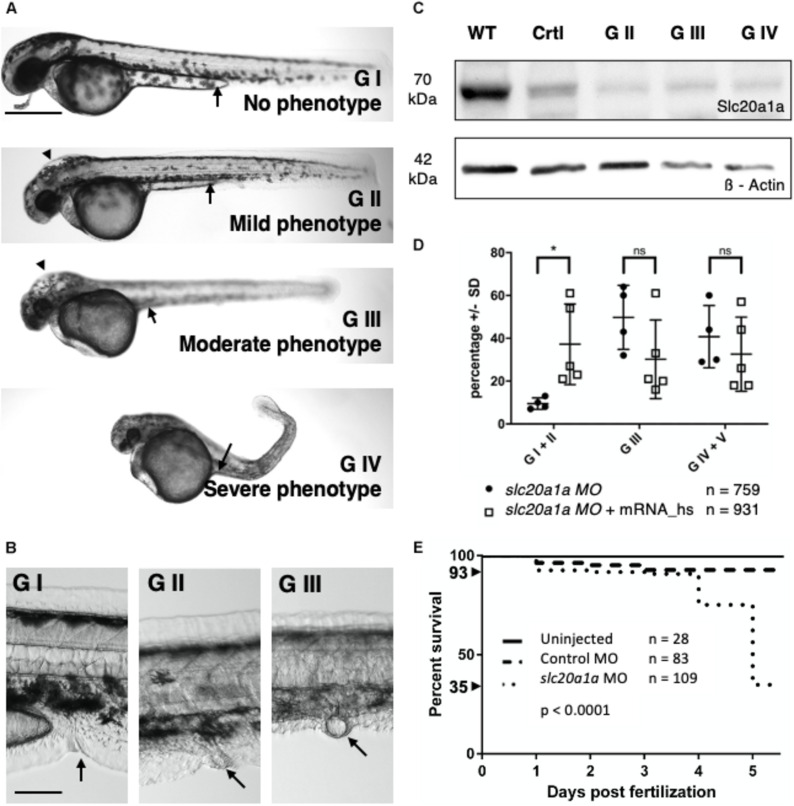
slc20a1a MO KD. KD was performed by injecting 0.75 ng of ATG-blocking MO into one-cell-staged wt zf eggs. Lateral view, dorsal to top, cranial on the left. (A) Phenotypical grading of MO injected zfl at 2 dpf in four grades increasing in severity and lethality. Scale bar: 500 μm. See main Results text for grading details. In brief, GI were normal in direct inspection; GII had mild defects; GIII had moderate defects, and GIV had severe defects. G V resembles dead zfl. Supplementary Data Sheet S3 shows close-ups for better demonstration of hydrocephalus and eye development in all four grades presented. (B) Examples for cloacal abnormalities in MO KD zfl at 2 dpf. Scale bar: 100 μm. Inspection of cloacal region after previous grading revealed malformations in cloacal region in G II and G III sorted zfl increasing in amount and severity with grading. G I sorted zfl had normal cloacal morphology, that is, a thin and curved organ with a distal opening (arrow). GII and GIII zfl have abnormally shaped cloacae, with dilated and/or apparently blind-ending lumens. Further cloacal close-ups of G II and III sorted zfl are shown in Supplementary Data Sheet S4. (C) WB shows efficacy of MO KD in zebrafish protein lysates from 2 dpf. 70 kDa: slc20a1a, 42 kDa: ß-Actin loading control; WT = uninjected control, Crtl = control MO injected, G II/III/IV = slc20a1a MO KD zfl sorted by grading II–IV. Slc20a1a can be detected in uninjected wt control and injected control MO group. Only a weak slc20a1a signal was seen in MO KD groups G II, III, and IV, which showed phenotypical features as described in (A). WB shows correlation between phenotype and protein expression. Raw data of WB is shown in Supplementary Data Sheet S6. (D) Co-injection of slc20a1a MO with 35 μg in vitro transcribed human SLC20A1 polyA mRNA shows partial rescue of various phenotypes underlining the Morpholino’s specificity. n = 5 (here n = 1 represents the average score in each experimental batch). Error bars show SD. X-axis shows groups at 3 dpf that were compared: zfl showing no or only a very mild phenotype (G I + G II), larvae with a moderate phenotype (G III) and a last group of larvae with a severe and lethal phenotype (G IV) together with those who were already dead at time of comparison (G V). Y-axis shows the percentage of zfl in the corresponding groups described before. A significant difference (∗p = 0.01) was seen within the first group of MO and MO-mRNA rescue group, showing a partial rescue of slc20a1a MO KD phenotype reflected in bigger group of phenotypically not or only mildly affected zfl. Mere overexpression of SLC20A1 wt mRNA in zfl resulted in phenotypical aberrations, which did not fit the grading characteristics and the phenotypes observed in slc20a1a MO KD. Further, pure SLC20A1 overexpression in zfl resulted in higher lethality compared to non-injected control groups (data not shown). These findings suggest that the MO rescue effect of SLC20A1 wt mRNA is weakened and disguised by the mRNA’s general negative overexpression effect. (E) Kaplan-Meyer curve shows significantly reduced survival (p < 0.0001) in slc20a1a MO-injected group compared to uninjected and control MO. Survival rates by day five post-fertilization: WT = 100%, control MO injected group = 93%, MO injected group = 35% (including all grades). Exclusion of embryos dying/not developing by 8 h post-fertilization (hpf) due to failed fertilization or consequences of tissue damage caused by injections with mechanical manipulation. Within these initial 8 hpf intervals, no difference was seen between control MO and slc20a1a MO injected groups.